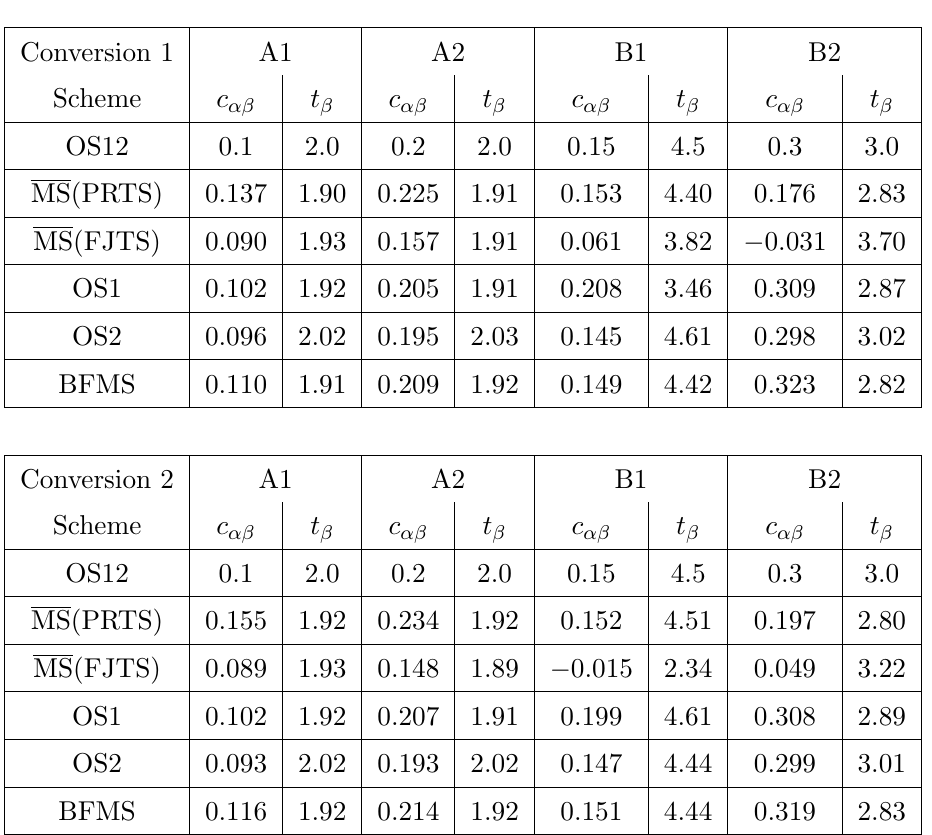
Table 15 . Conversion of parameters from the OS12 scheme as input scheme to other renormal- ization schemes at the central scale (cid:22) 0 performed in the PRTS (upper table, used for the Higgs decays in section 4.1.2) and FJTS (lower table, used for Higgs-production processes in sections 4.2.3 and 4.2.4) tadpole scheme. Besides the choice of tadpole counterterm scheme, also the bare param- eters for the matching di(cid:11)ers. In the upper table tan (cid:11) B and tan (cid:12) B are used while in the lower one (cid:11) B and (cid:12) B are